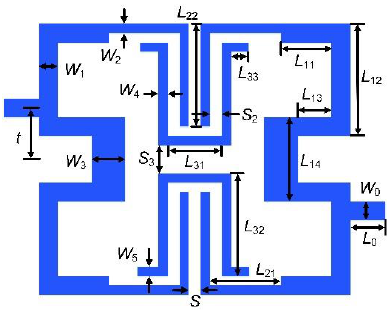
Figure 5. Schematic diagram of tri-wideband BPF.